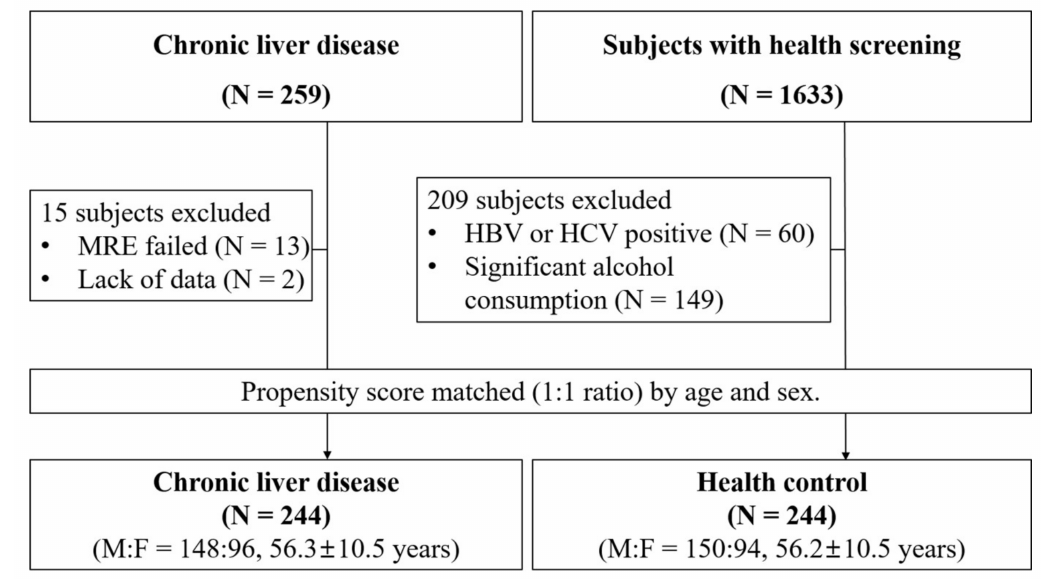
Figure 1. The diagram shows patient selection for the